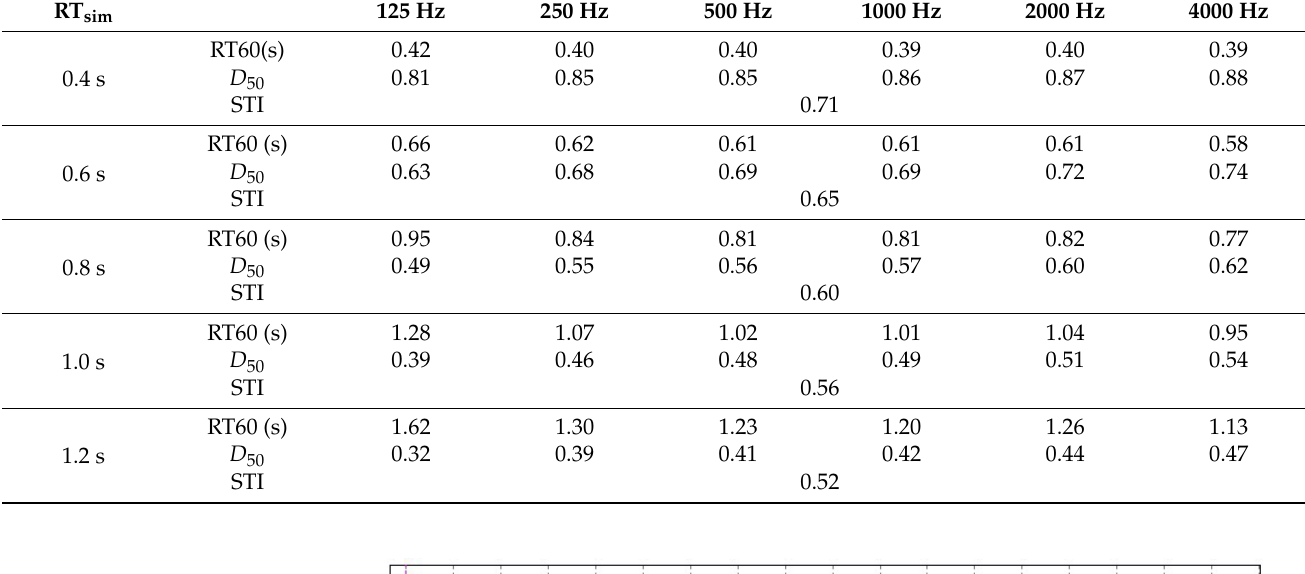
Table 6. Acoustical parameters of virtual sound field.